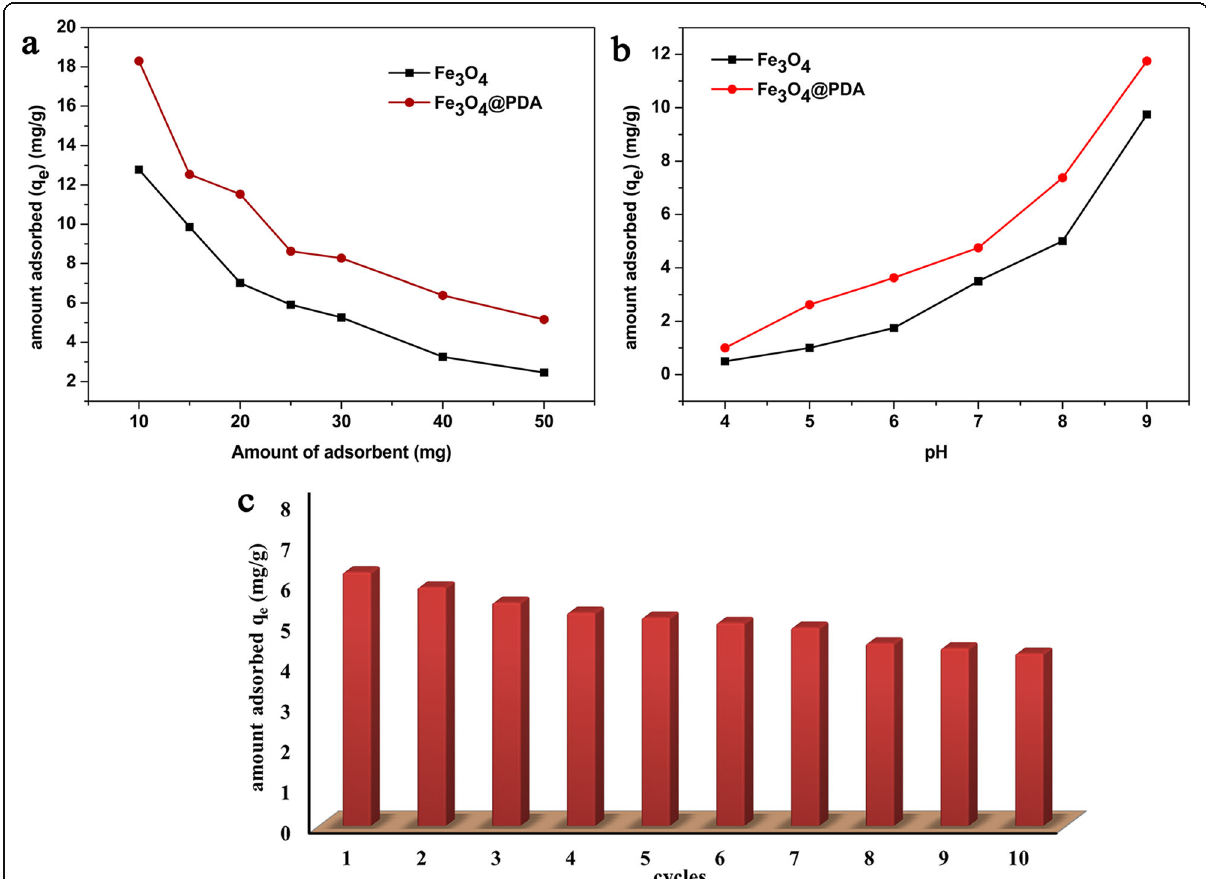
Fig. 7 a Effect of different adsorbent doses on the adsorption of Cd 2+ , b effect of pH on the uptake of metal ions by the adsorbents, and c variation of the adsorption capacity of Fe 3 O 4 @PDA for Cd 2+ with the number of adsorption – desorption